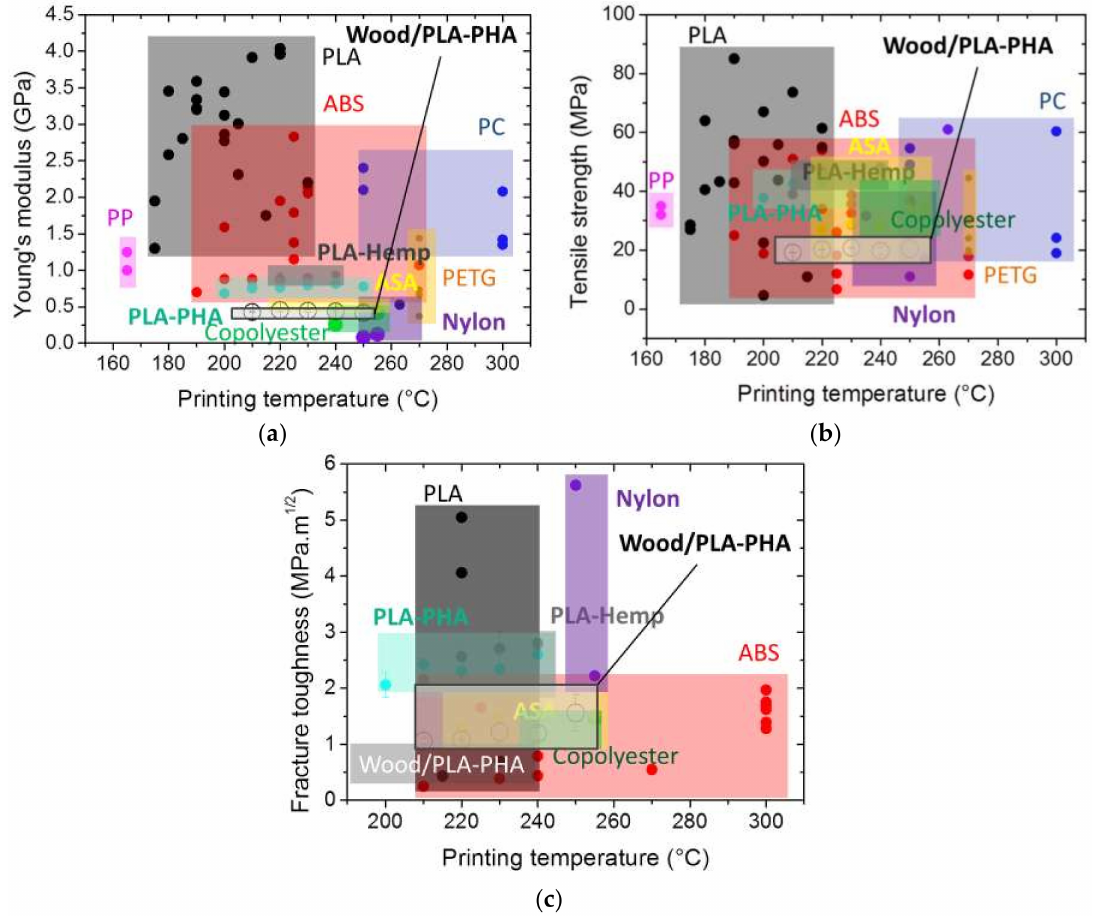
Figure 7. Tensile performance of varieties of polymers used in FDM including the wood-PLA / PHA considered in this study. ( a ) Sti ff ness, ( b ) strength, and ( c ) toughness. The performance of wood-based filament is